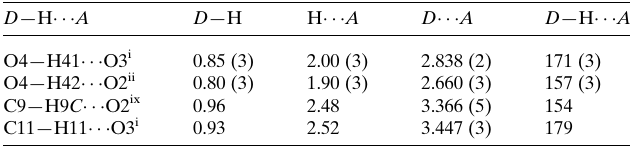
Table 1 Hydrogen-bond geometry (A˚ , (cid:2) ).